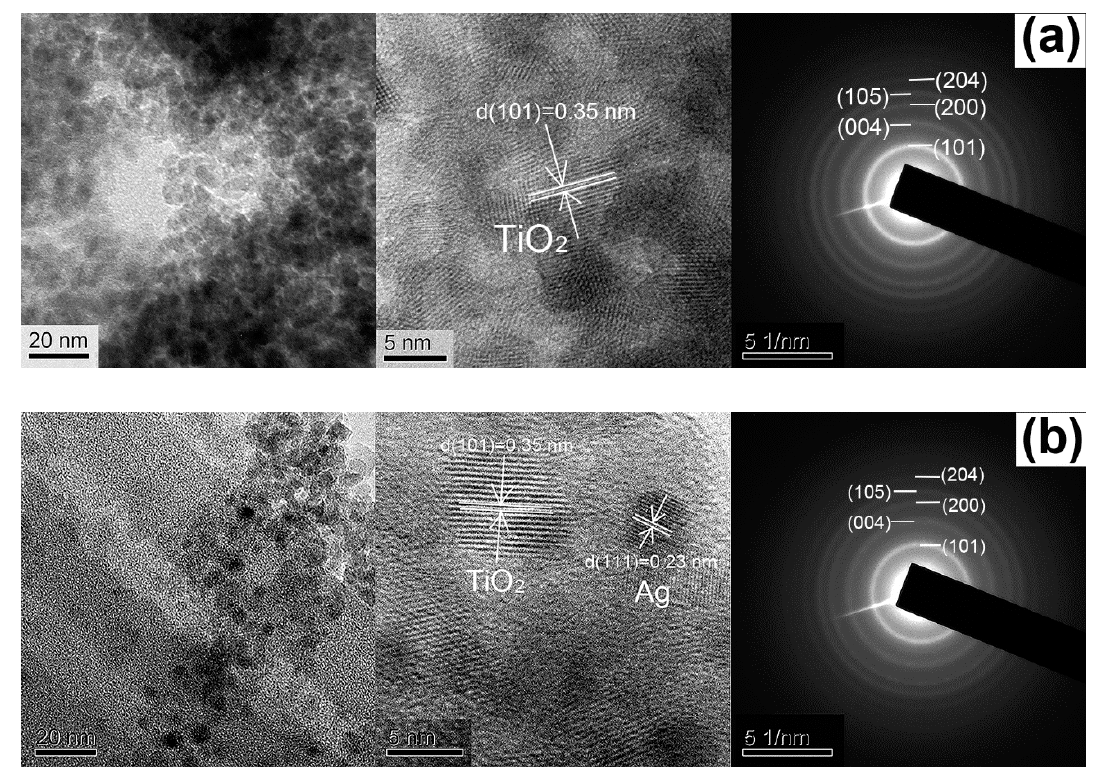
Figure 3. The transmission electron microscopy (TEM) and high resolution TEM (HRTEM) images and selected area electron diffraction (SAED) patterns of as-synthesized TiO 2 nanoparticles obtained from the ( a ) P–1 and ( b ) P–2